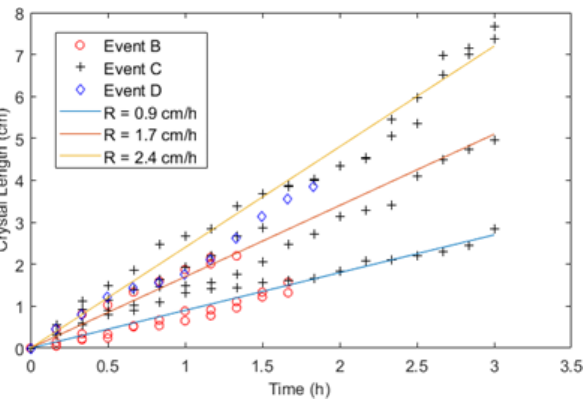
Figure 12. Time series of individual crystal growth (Stage 1) mea- sured from events B, C, and D. For illustrative purposes, linear growth rates of R = 0 . 9, 1.7, and 2.4cm/h were added to the plot.